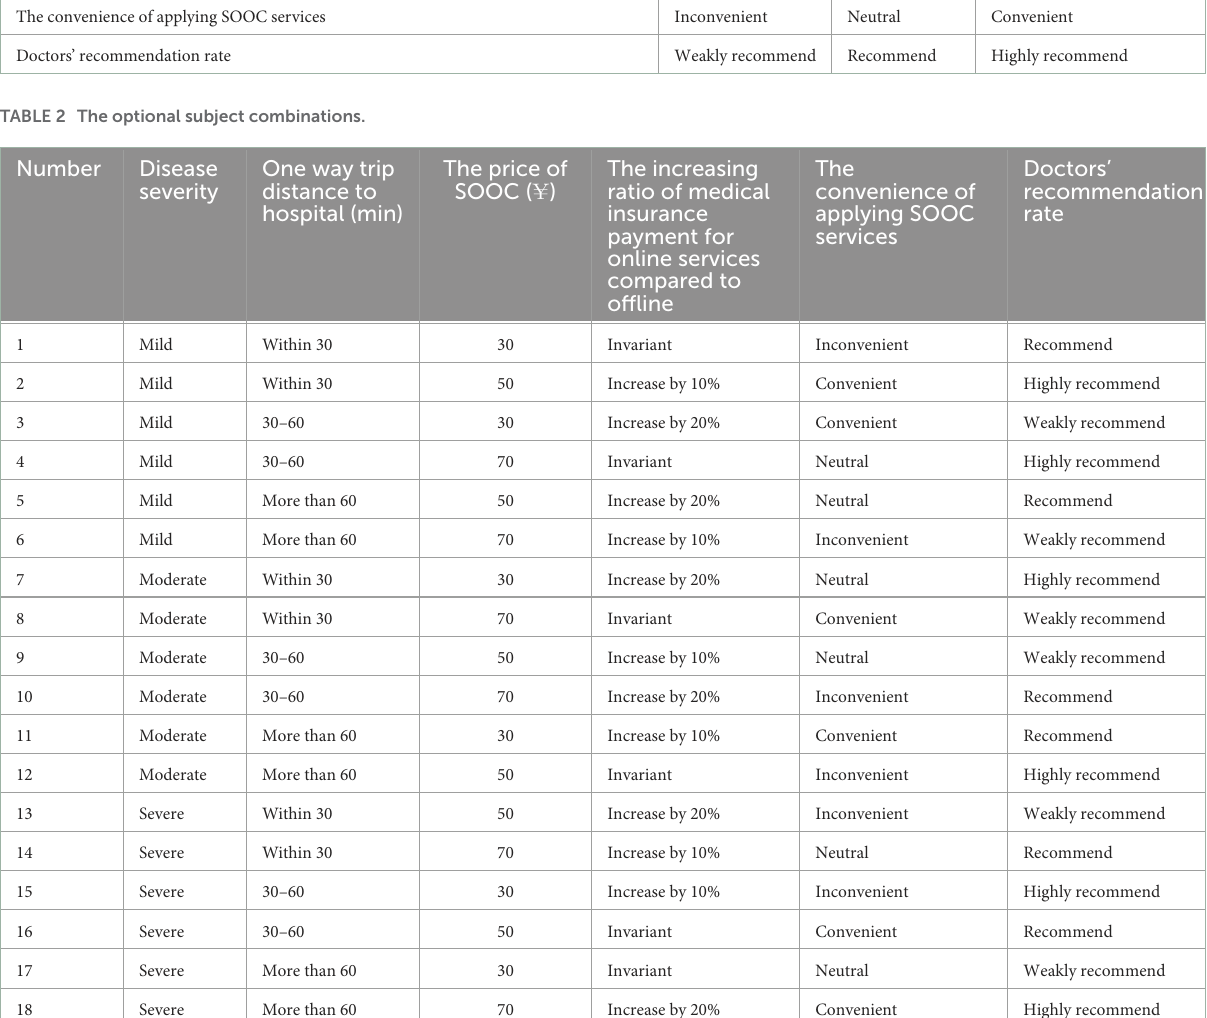
TABLE 2 The optional subject